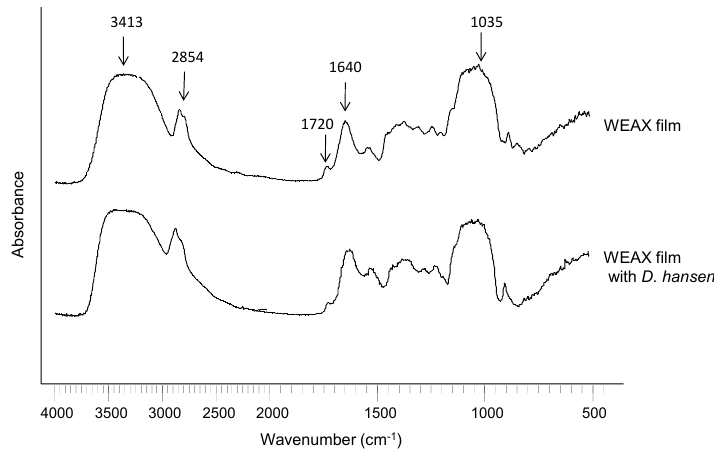
Figure 6. FT-IR spectra of cross-linked WEAX film and cross-linked WEAX film containing D. hansenii